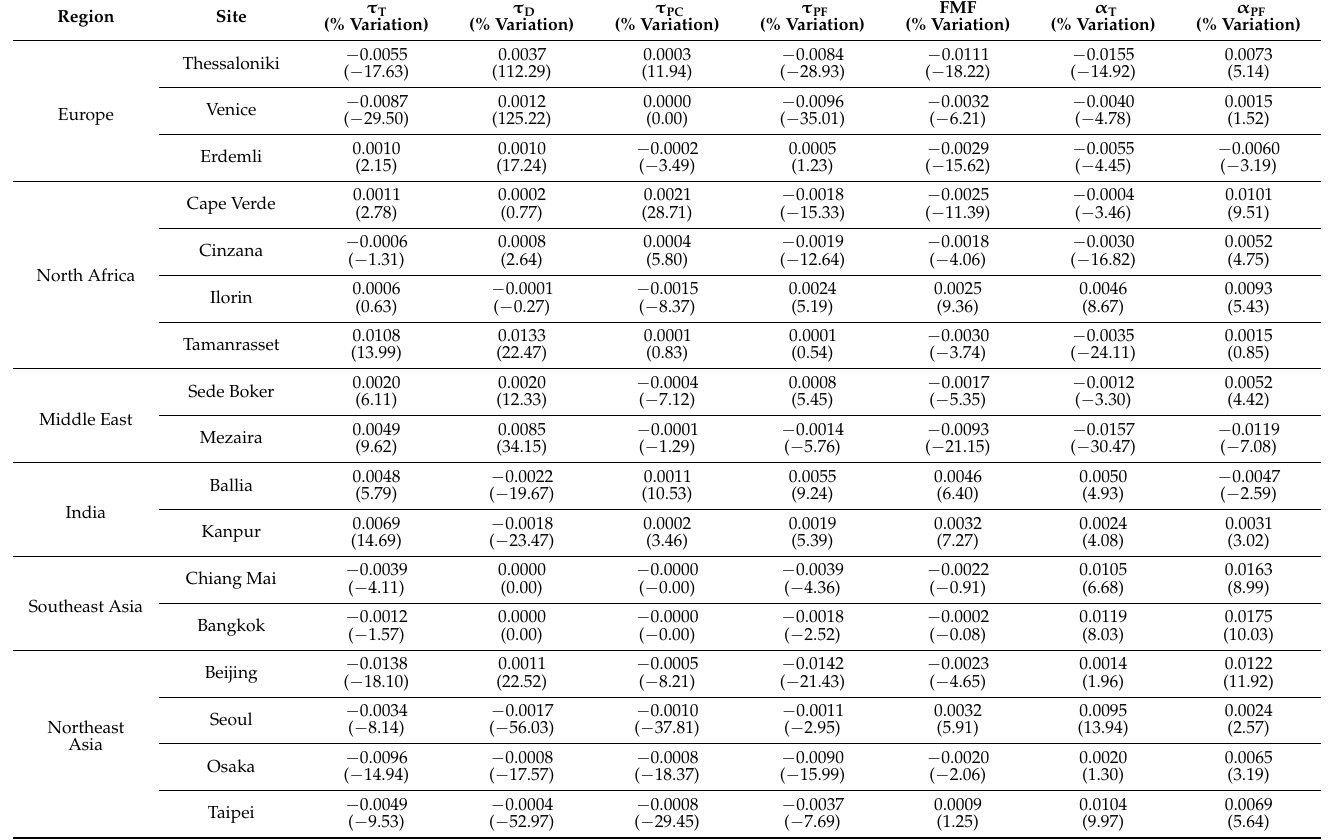
Table 2. Change of the annual value ( τ yr − 1 or yr − 1 ) and the percent variation (%) of τ T , τ D , τ PC , τ PF , FMF, α T and α PF based on the slope obtained from linear regression method. The wavelength of τ T , τ τ τ D , PC , and PF is 440 nm and that of